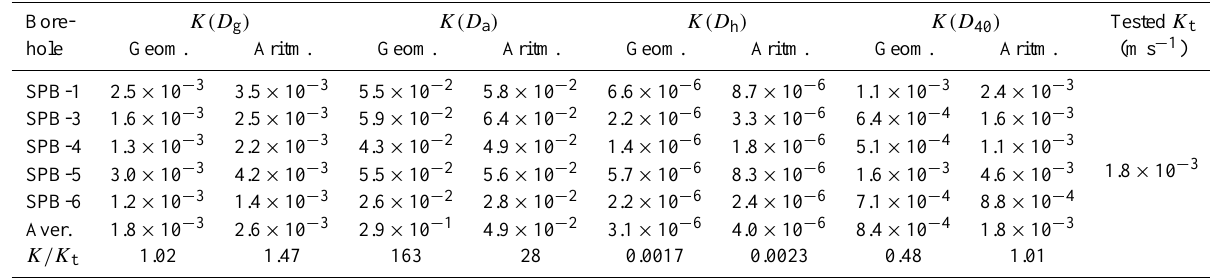
Table 2. Average predicted hydraulic conductivity K (ms − 1 ) for boreholes in the gravelly aquifer (test field GW). Bore- K(D g ) K(D a ) K(D h ) K(D 40 ) Tested K t hole Geom. Aritm. Geom. Aritm. Geom. Aritm. Geom. Aritm. SPB-1